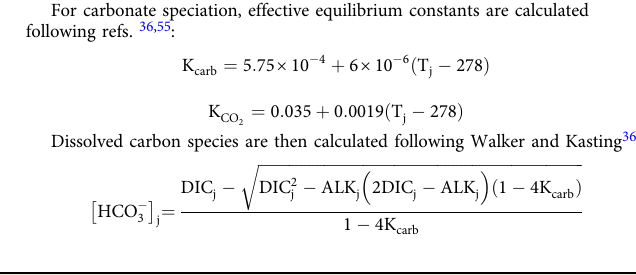
where k clim is climate sensitivity to doubling CO 2 , and t geol is time in millions of years before present and is expressed in negative terms. Low-latitude surface temperature (T s ) is assumed to scale by 2 times global temperature change, and 3 both high-latitude (T h ) and deep (T d ) temperature are assumed to follow global temperature change. For carbonate speciation, effective equilibrium constants are calculated following refs. 36,55 :